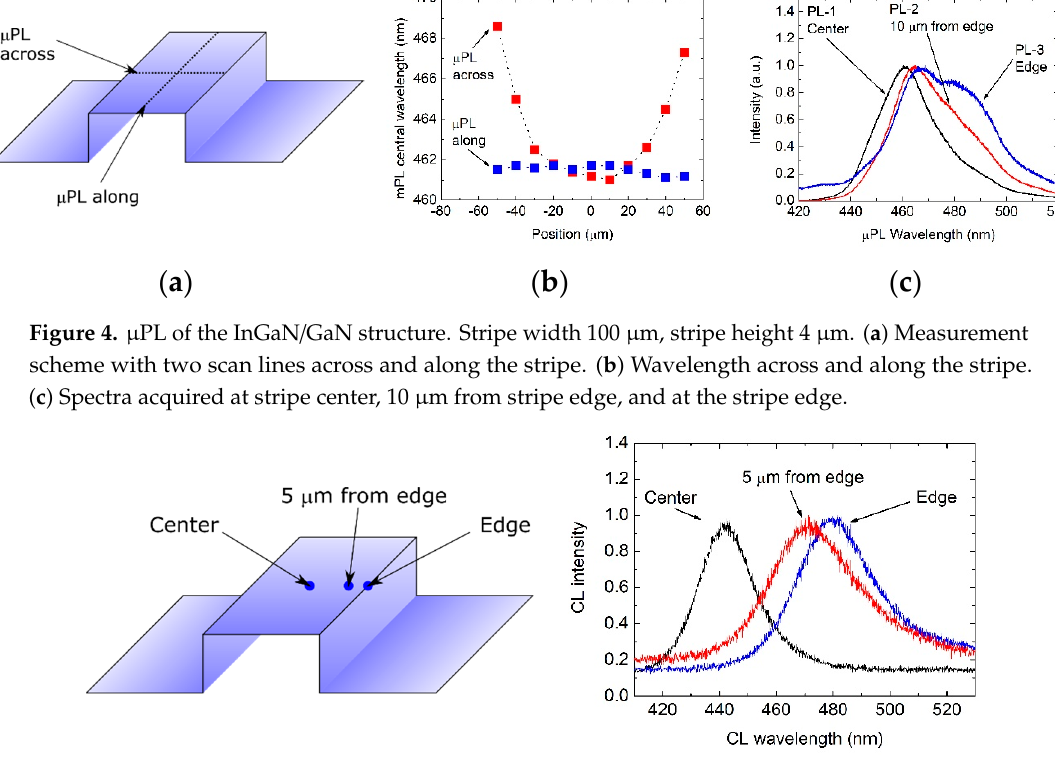
( b ) ( c ) Figure 3. Micro-photoluminescence (µPL) of nominally identical InGaN/GaN structures grown on substrates with 4 μ m high stripes using vertical and horizontal reactors. ( a ) Central wavelength of µPL as a function of stripe width, ( b ) normalized µPL spectra of structure grown using a vertical reactor, ( c ) normalized µPL spectra of structure grown using a horizontal reactor. In the next step we studied optical properties of our structure with single QW grown using a vertical, and also a horizontal reactor, in more detail. For both samples we performed µPL scans along and across stripes in all regions P5–P100, as shown in Figure 4a. We also made CL measurements in three spots on top of the 50 µm wide stripe—in the center, 5 µm from the edge, and at the edge, as